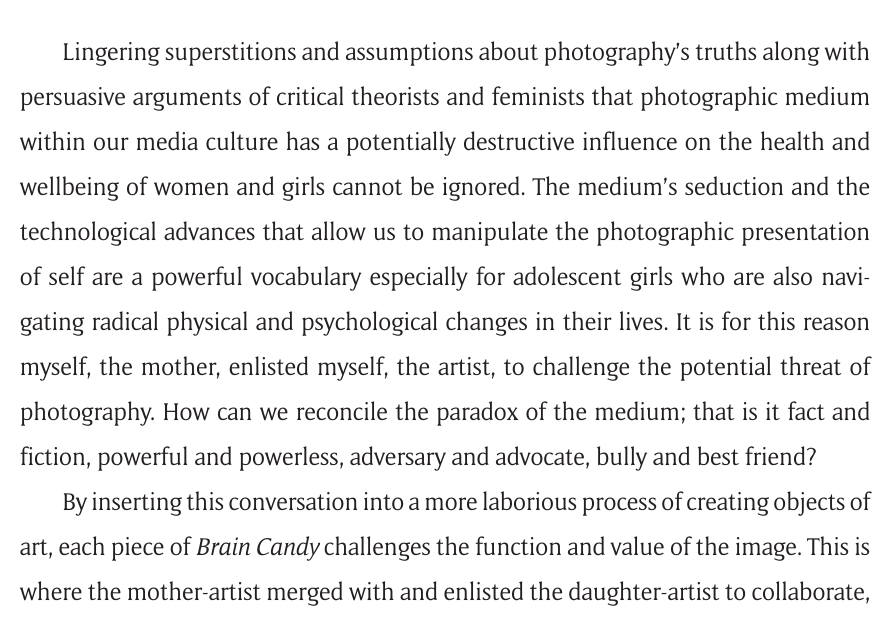
Figure 5: Brain Candy: Shhh in a Suit,